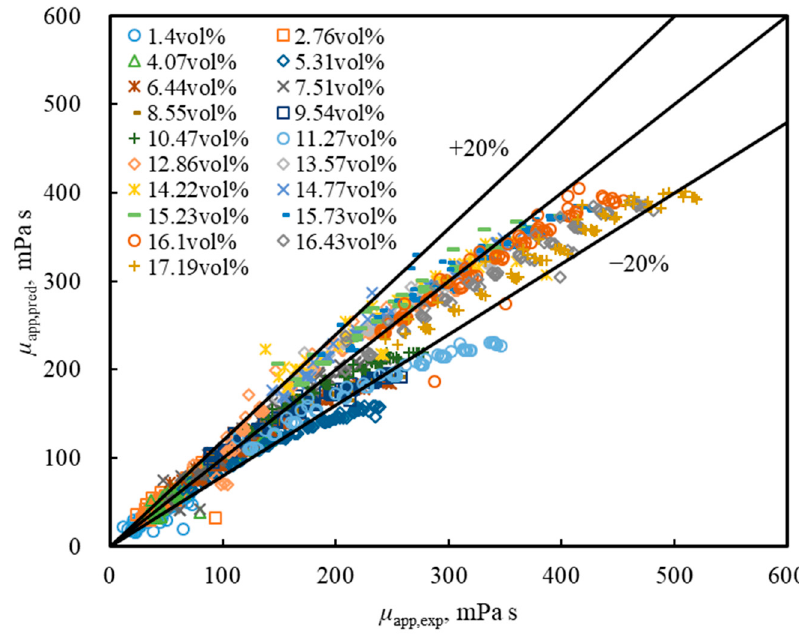
Figure 9. Comparison between experimental data and predicted apparent viscosity.